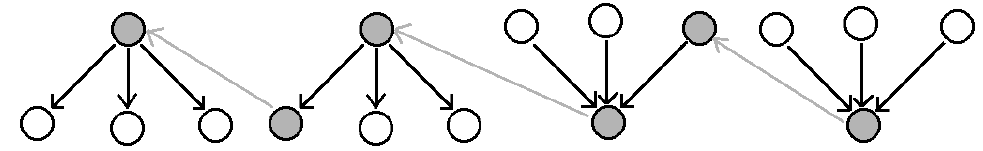
Figure 4. Introduction of M + N − 1 additional